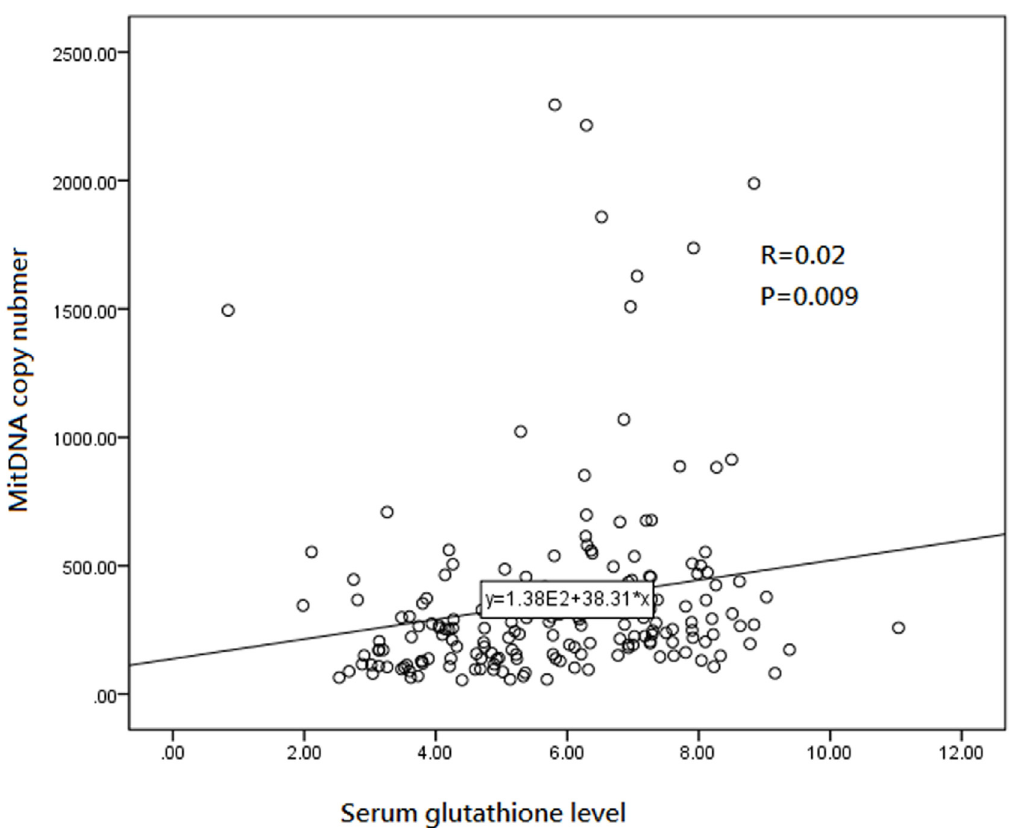
Fig 2. Relative mtDNA copy number of peripheral leukocytes correlates with serum glutathione level. Pearson correlation test shows a significant liner correlation between mtDNA copy number and serum glutathione level (R = 0.2, P = 0.009).